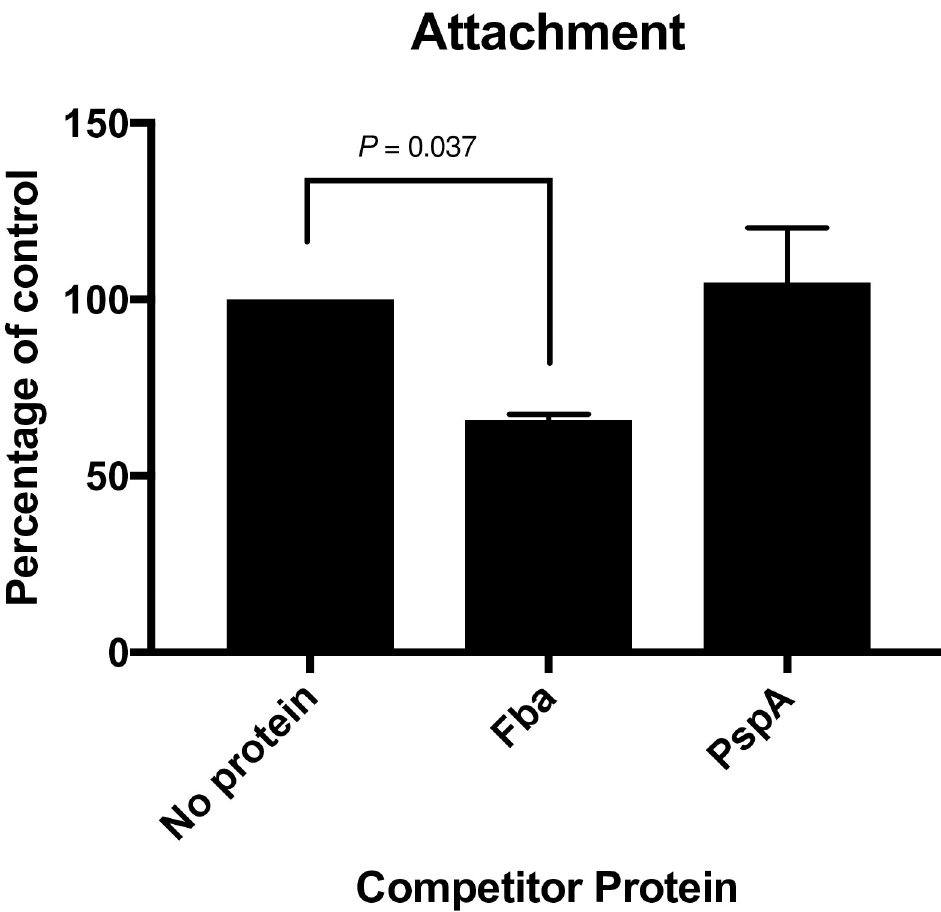
Fig 6. Adherence of C . perfringens CP4 to Caco-2 cells in the presence or absence of purified rFba or rPspA. Attachment results significantly different from the no protein controls are indicated. We recovered an average of 2.4 x 10 3 CFU of C . perfringens CP4 from the no protein and PspA control